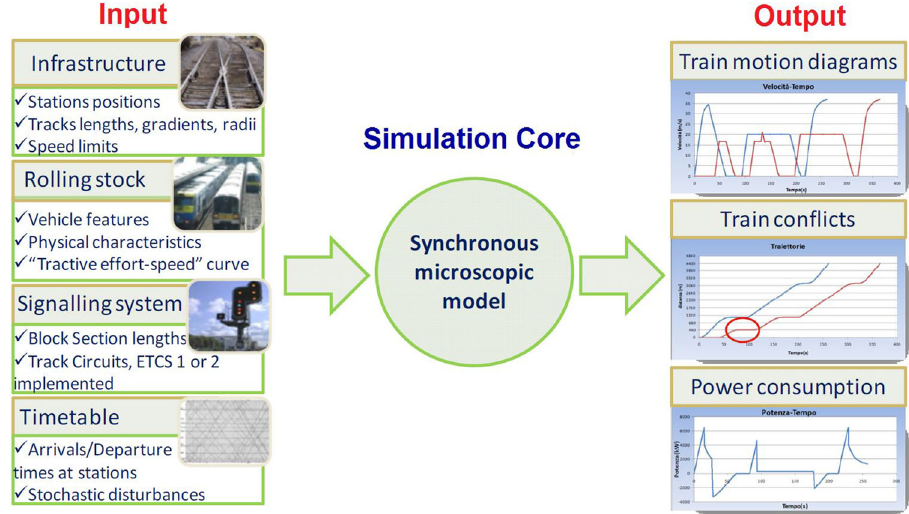
Fig. 8 EGTRAIN framework